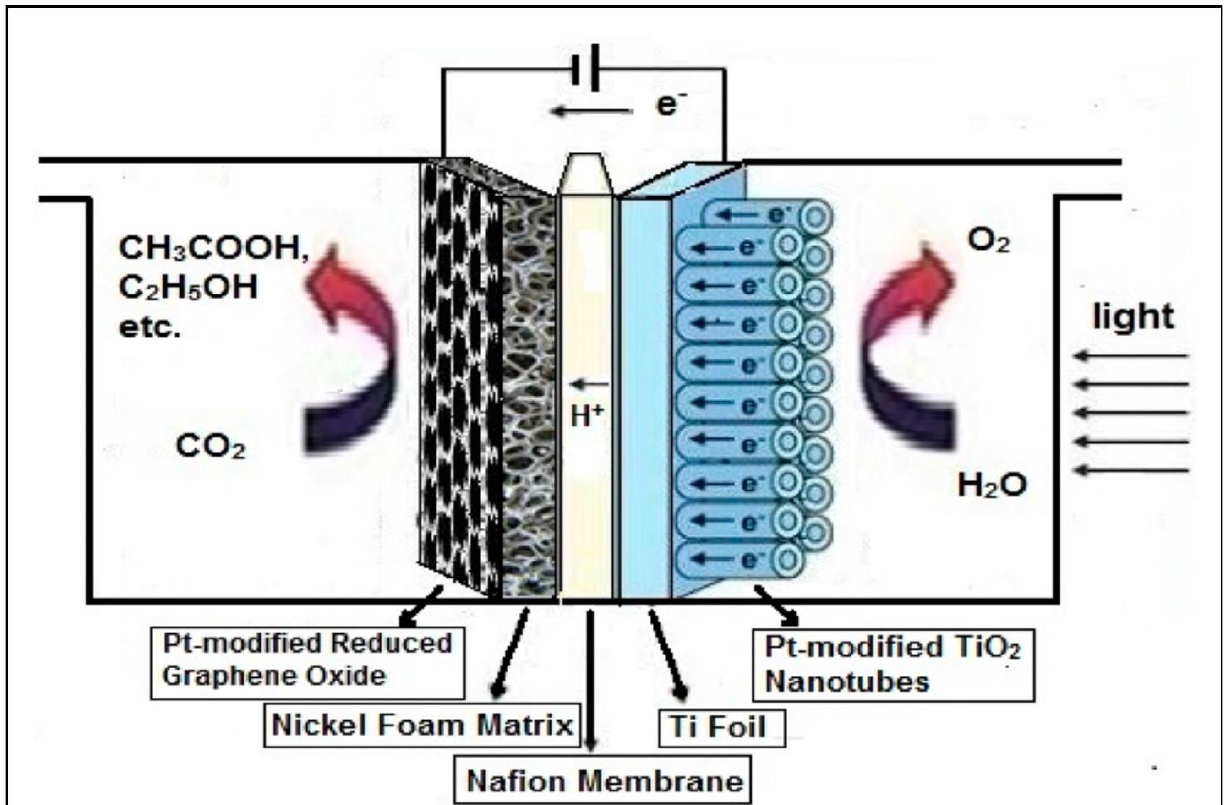
Figure 9. Development of a new photoelectrochemical device for transforming CO 2 into valuable products. Reprinted with permission from Ref. [122].